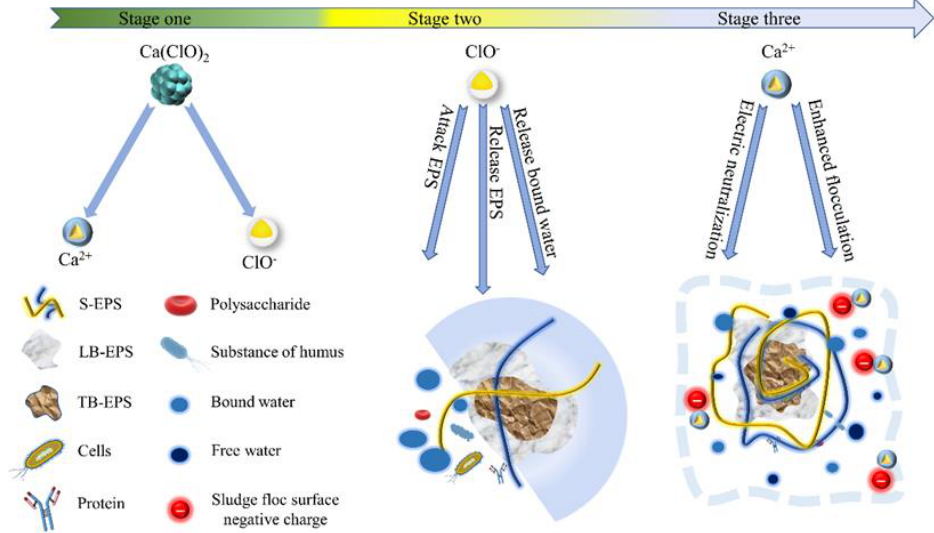
Figure 9. Ca(ClO) 2 sludge conditioning mechanism. Table 4. Efficiency of different types of oxidation techniques for conditioning sludge.